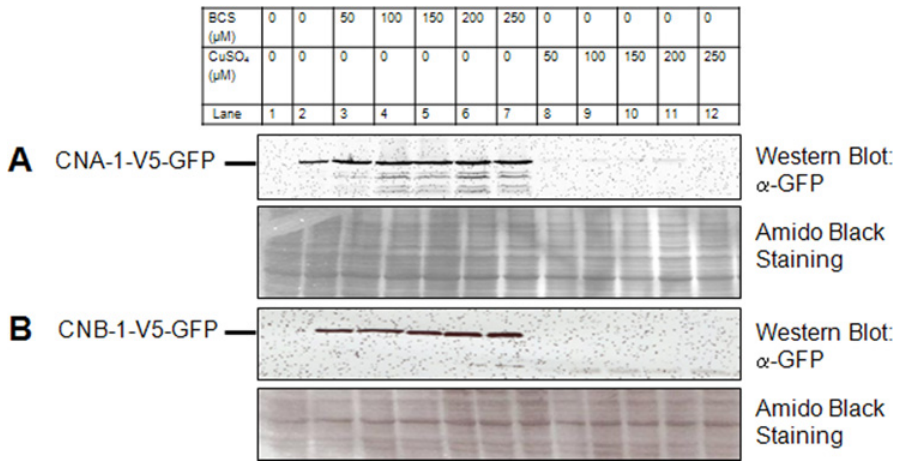
Fig 1. Copper-regulated expression of CNA-1 and CNB-1 under control of the tcu-1 promoter. The effect of BCS or copper sulfate on P tcu-1 driven expression of CNA-1 from the Δ cna-1 :: hph; Δ pan-2 ::P tcu-1 :: cna-1 :: v5 :: gfp; mat a (540) strain (A) , and CNB-1 from the Δ cnb-1 :: hph; Δ pan-2 ::P tcu-1 :: cnb-1 :: v5 :: gfp; mat a (597) strain (B) was determined (lanes 2 – 12) after growth of strains in liquid medium under the indicated conditions for 22 h. Protein isolated from the wild type strain (FGSC 2489) was used as control (lane 1). Protein extracts were prepared and samples containing 50 μ g of total protein were analyzed by Western blot using rabbit anti-GFP antibody as indicated in the Materials and Methods. The solid lines indicate positions of CNA-1::V5::GFP (~93 kDa) and CNB-1::V5::GFP (~48 kDa) proteins. The amido black staining of the membrane, shown in the lower panel, was done to demonstrate equal protein